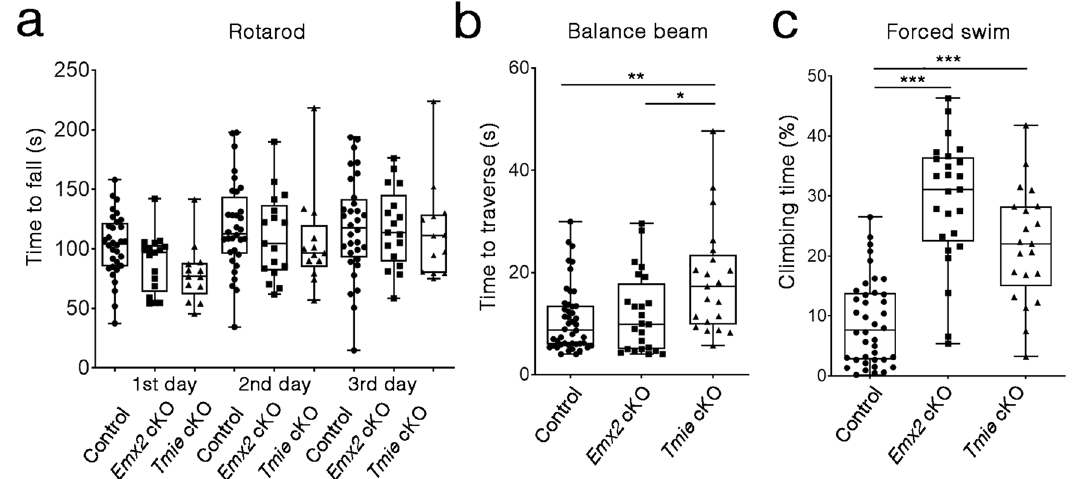
n =21, Emx2 cKO vs Tmie cKO * p =0.02, control vs Tmie cKO ** p =0.0013). c Percentages of time mice spent climbing during the 1-min period in water. Emx2 cKO and Tmie cKO spent moretime climbing inwater,whencompared to controls (control n =40; Emx2 cKO n =25; Tmie cKO n =21;controlvs Emx2 cKO*** p =2.64E − 13 and Tmie cKO *** p =1.72E − 07). In boxplots, boxes represent the interquartile range(IQR),andthethicklinesinsideshowthemedian.Whiskersdenotethelowest and highest values within 1.5 times the IQR. The one-way ANOVA with multiple comparisons was applied. Source data are provided as a Source data fi